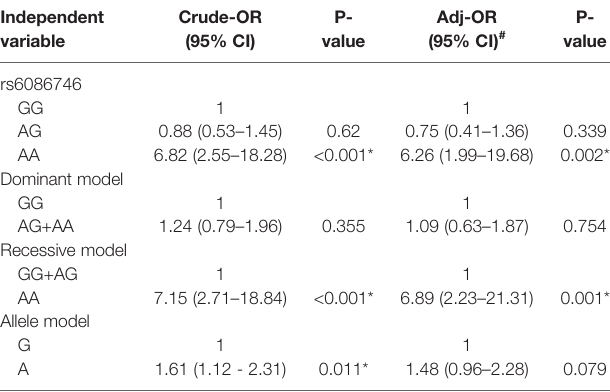
TABLE 4 | Association of the rs6086746 with osteoporosis. Independent